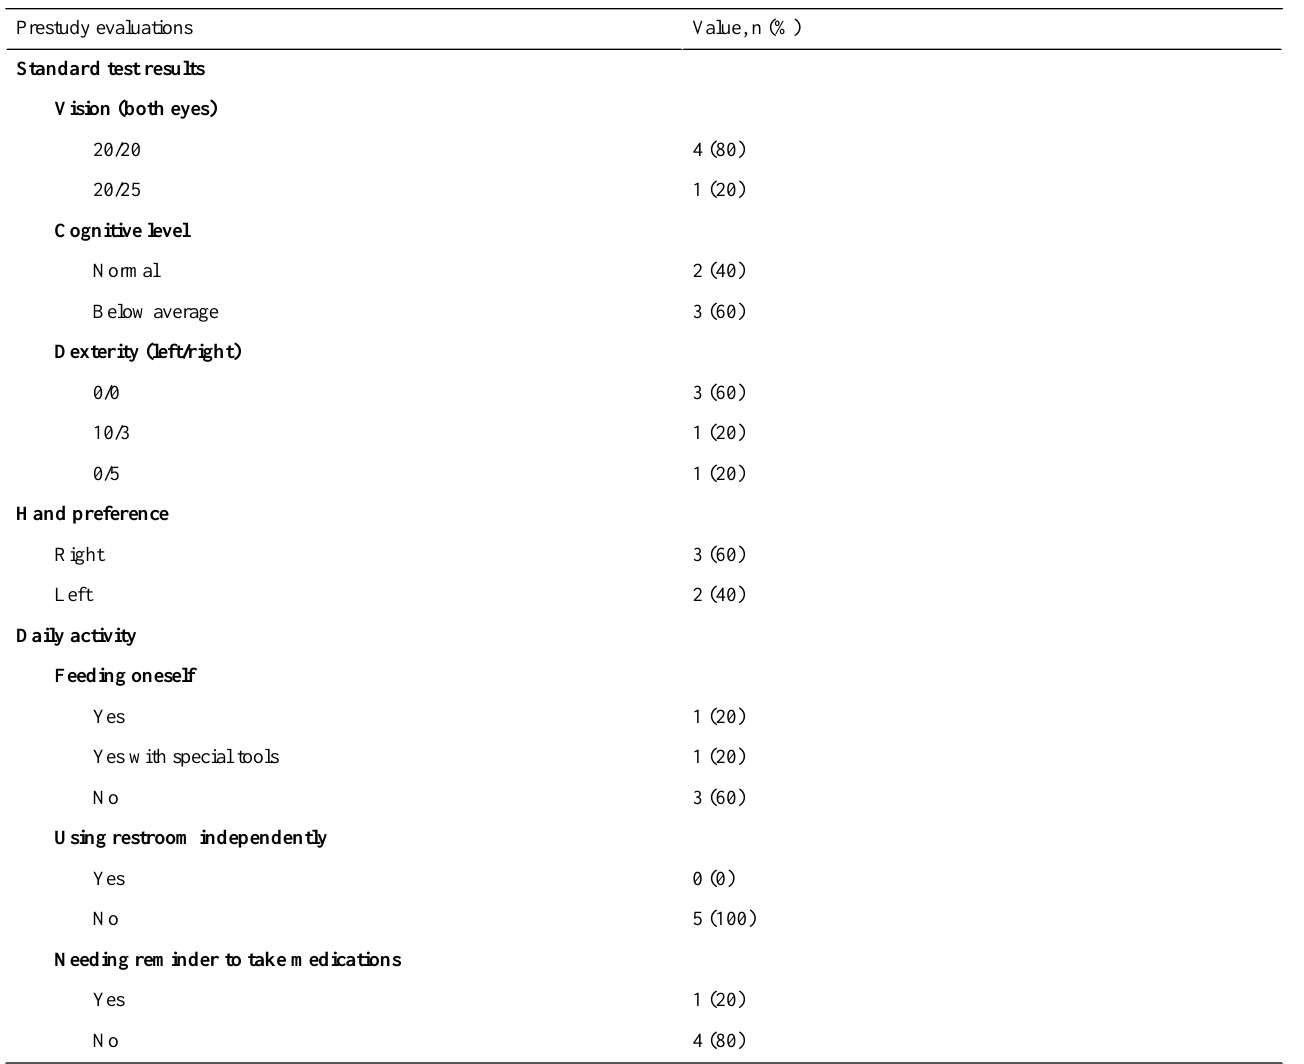
Table 2. Standard test results, hand preference, and difficulty performing daily